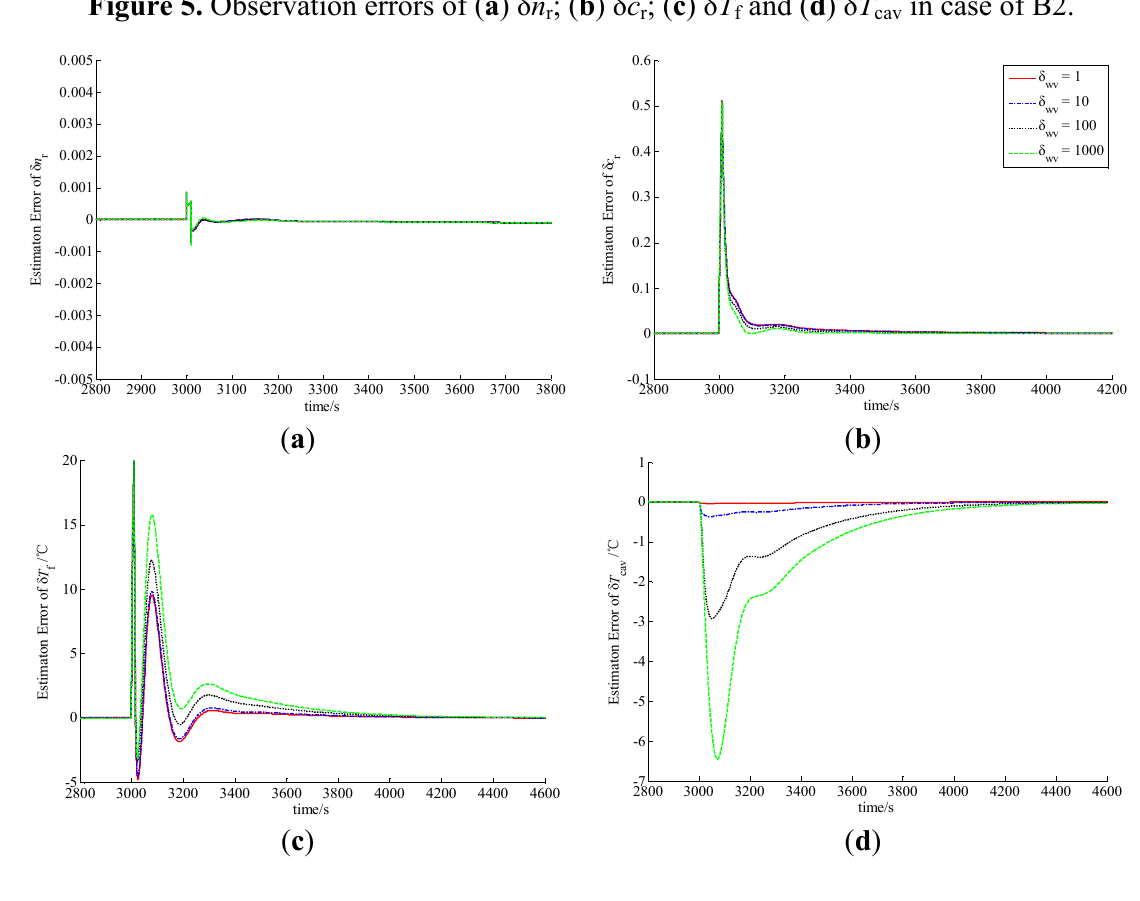
Figure 5. Observation errors of ( a ) δ n